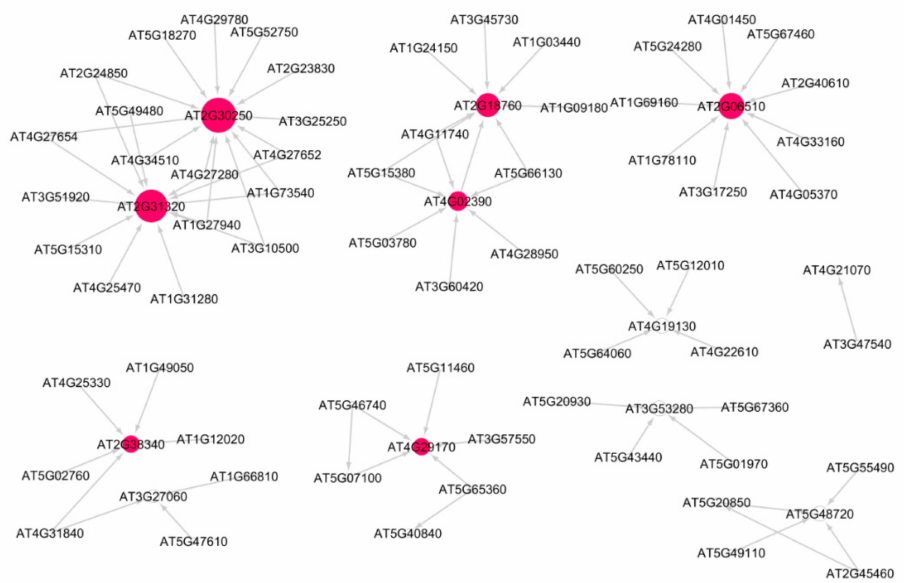
Figure 2. Subnetwork for cellular response to stress process in Arabidopsis under low radiation dose (LRD3) dataset. Red circles are hub genes. There are 7 significant hub genes in this subnetwork. Larger the circles, higher the value of in-degree distribution.